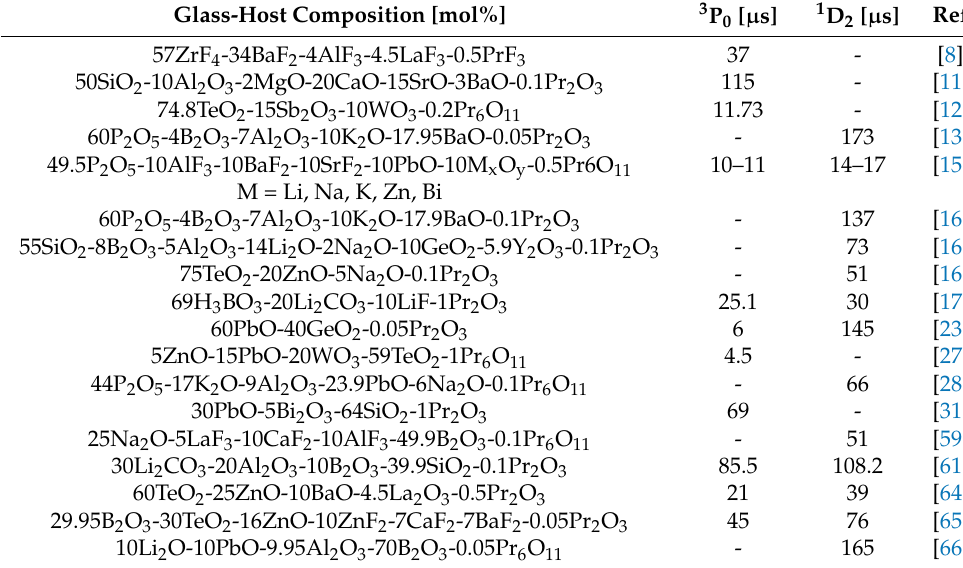
Table 4. Also, the x and y of CIE chromaticity coordinates for IZSBGL-Pr, GBFG-Pr, GBG-Pr, PPG-Pr, and BBG-Pr systems were calculated from the emission spectra. The results are given in Table 5. They are shown in the chromaticity diagram in Figure 4. Table 4. Luminescence lifetimes for 3 P 0 and 1 D 2 states of Pr 3+ ions in inorganic glasses. Glass-Host Composition [mol%]